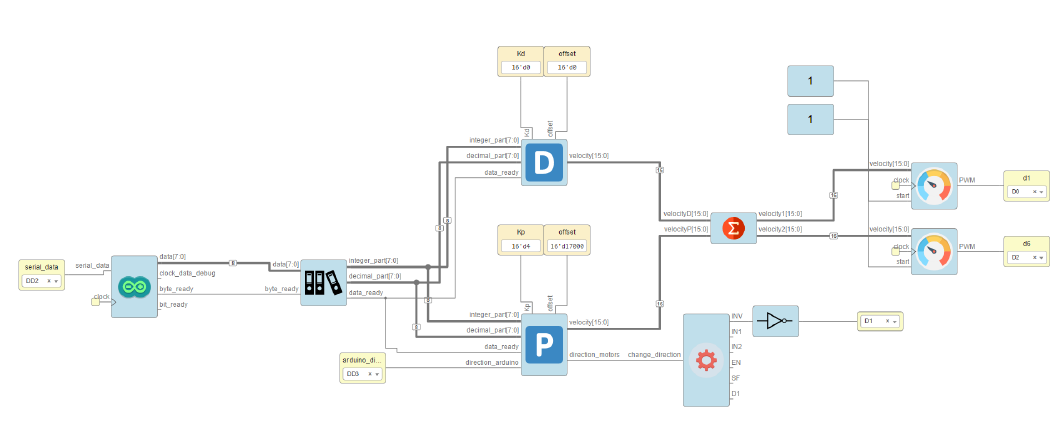
Figure 12. Final appearance of the self-balancing in IceStudio.